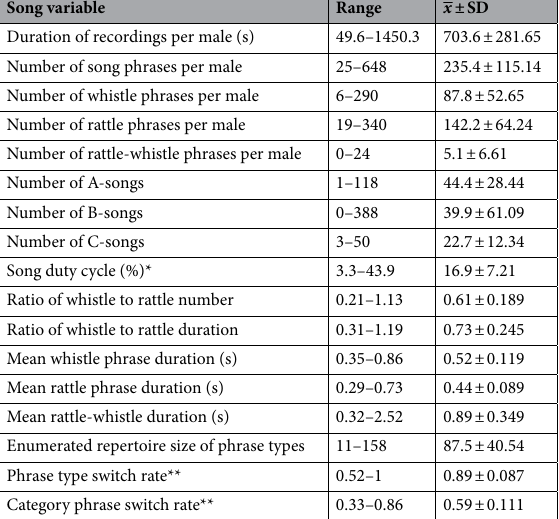
Table 1. Basic parameters of the Aquatic Warbler Acrocephalus paludicola recordings (N = 40 birds). *Percentage of time spent singing in the total recording time. **Switch rate is the number of switches from one phrase (category) type to a different one, divided by the total number of possible switches within a recording, which is equal to the number of phrases minus one. The switch rate may range from 0 to 1, where 1 means that a male switches to a different phrase or category type every phrase.